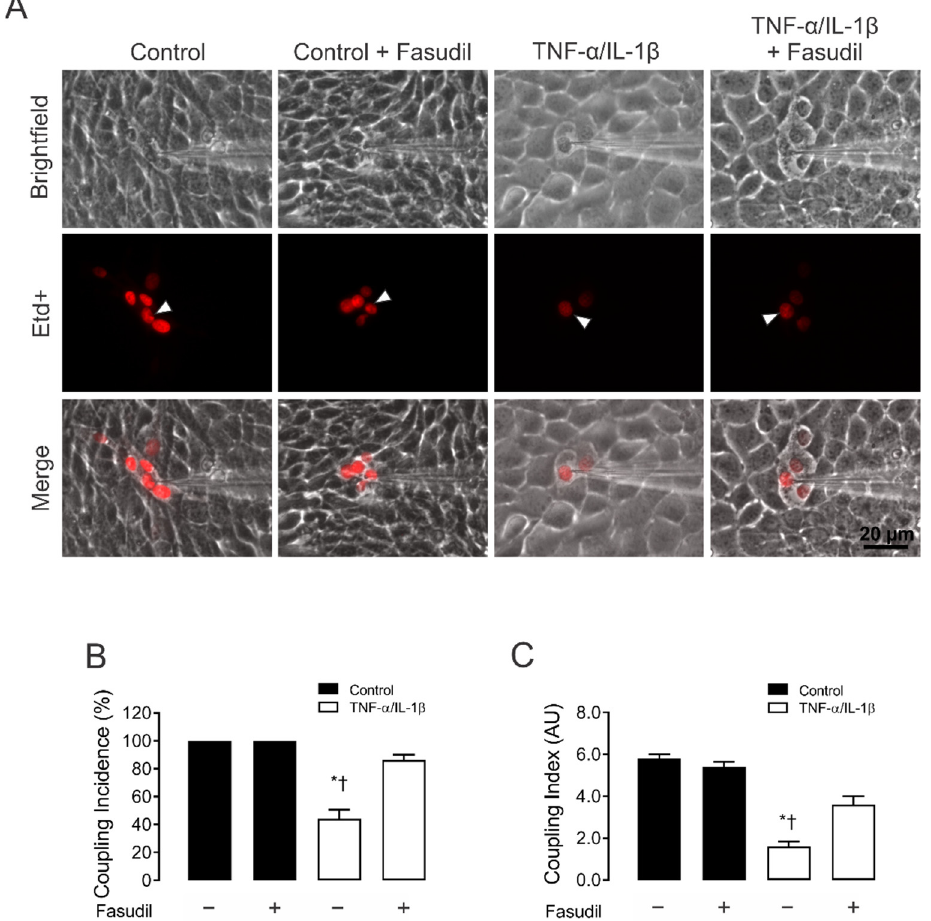
Figure 2. Fasudil prevents the TNF- α /IL-1 β -induced reduction in gap junctional communication in MES-13 cells. ( A ) Gap junctional communication was examined using the microinjection of Etd + (25 µ M) in single cells (white arrows). After 2 min, the diffusion to neighboring cells was imaged. The top panels represent phase-contrast images, whereas the bottom panels show Etd + fluorescence in cells under control conditions or upon different treatments. Scale bar = 20 µ m. ( B ) Coupling incidence and ( C ) coupling index in confluent mesangial cells, under control conditions (black bars) or exposed to TNF- α /IL-1 β (10 ng/mL) for 72 h (white bars). Fasudil (15 µ M) was added together with TNF- α /IL-1 β . Each bar represents the mean value ± SEM of 4 independent experiments. In each experiment, the dye was microinjected into at least 10 cells. Statistical significance * p < 0.05 vs. Ctrl; † p < 0.05 vs. TNF- α /IL-1 β +